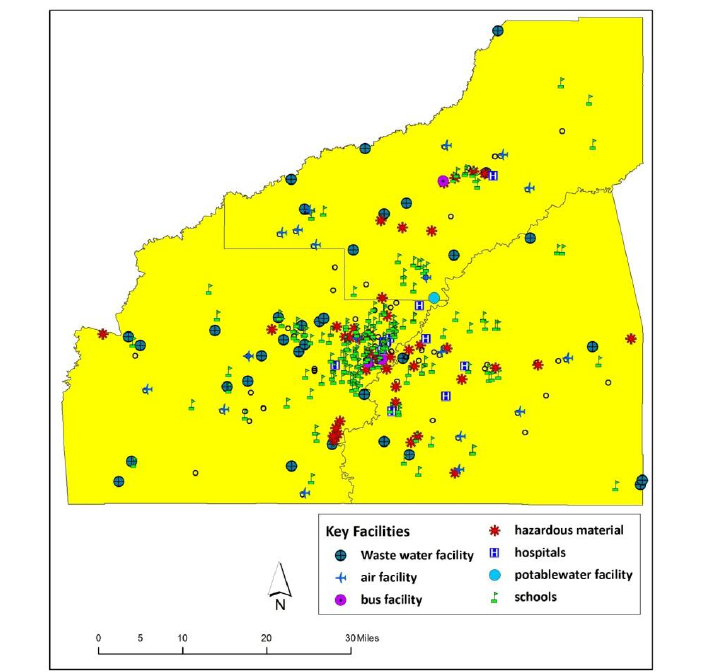
Figure 9 . Key facilities in Hinds, Rankin and Madison County, MS.